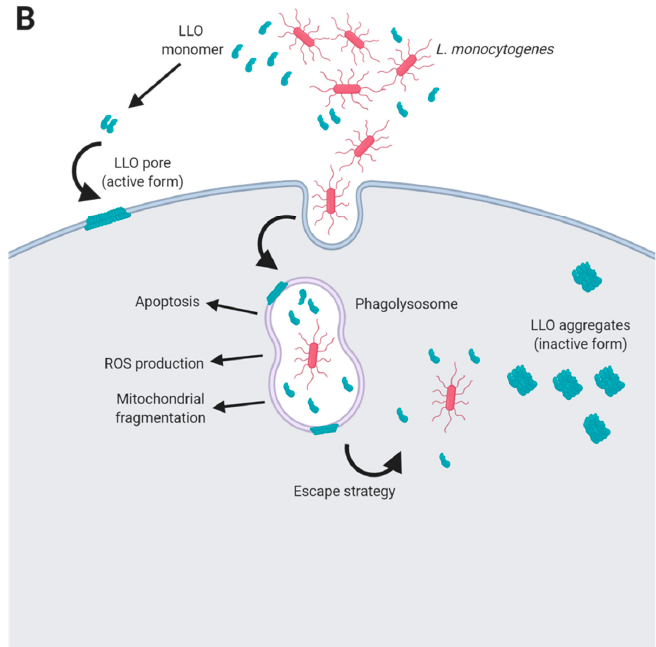
Figure 1. The role of functional amyloids as toxins. ( A ) Environmental conditions influence the aggregation state and kinetics of amyloid proteins. The folding of amyloid proteins into different structures is modulatedbyenvironmentalconditions, i.e., pH,asexemplifiedinthisfigure.Proteinmonomersareable to form stable dimers that adopt a beta-hairpin structure, which in contact with biological membranes switch to a β -barrel pore. Furthermore, monomers are able to assemble into oligomers that finally give rise to mature amyloid fibres. At non optimal conditions, misfolded monomers or oligomers tend to form amorphous aggregates that finally can lead to the formation of protofibrils or β -barrel pores when appropriate conditions are met. ( B ) Mechanism of action of LLO toxin of L. monocytogenes . The bacteria secretes monomers of LLO that form stable dimers that are able to oligomerize building pores through the interaction with biological membranes. Inside of the phagolysosome, the toxin is secreted by the bacteria, limiting ROS production and causing the lysis of the lysosome, which contributes to the survival of the pathogen. LLO is also implicated in apoptosis and mitochondrial fragmentation. At alkaline conditions, such as the ones found in the cytoplasm, LLO monomers are unable to polymerize and tend to form amyloid aggregates which inactivate the cytotoxic activity of the protein